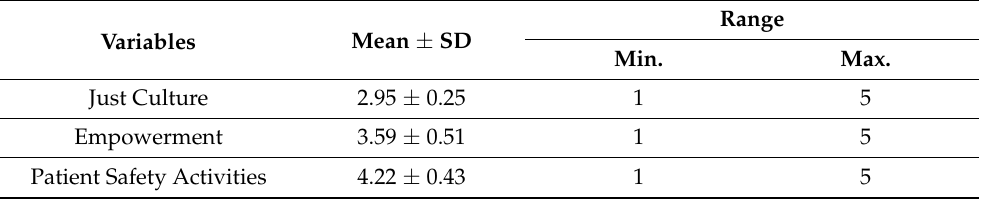
Table 1. Level of Just culture, Empowerment, and Patient Safety